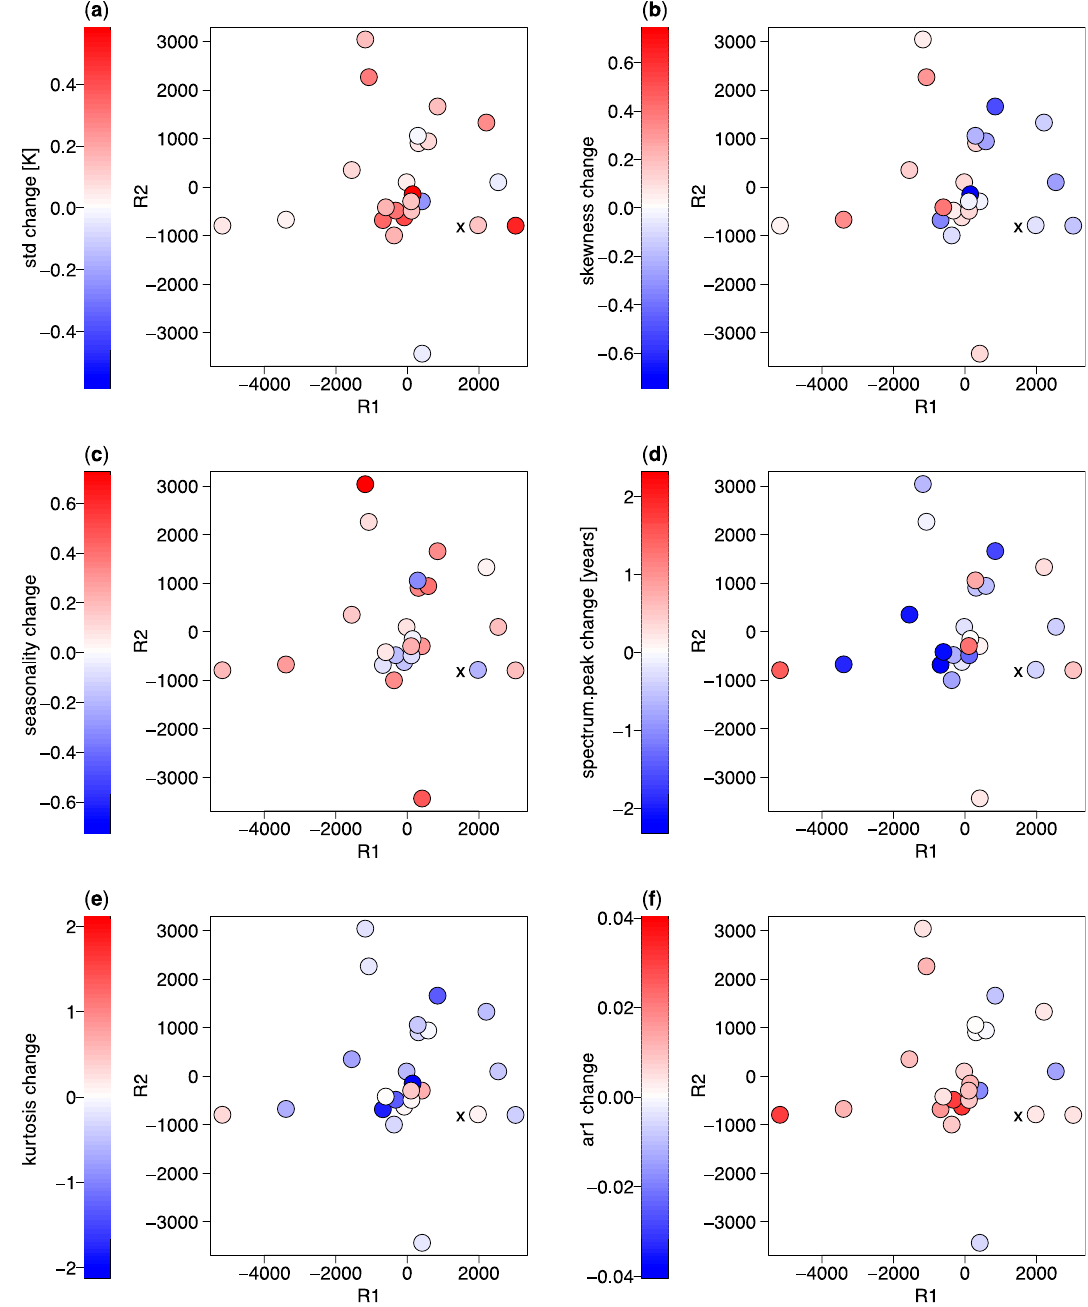
Figure 3. Results of multi-dimensional scaling (MDS) analysis of ENSO probability density functions from CMIP6 climate models. Changes between periods 1850–1949 to 2040–2099 as a function of MDS principal coordinates for Niño 3 ( a ) standard deviation, ( b ) skewness, ( c ) seasonality, ( d ) ENSO spectrum peak, ( e ) kurtosis and ( f ) autocorrelation from CMIP6 models (color) under the SSP585 forcing scenario. Observed coordinates are denoted by black crosses. R 1 and R 2 are the first two principal coordinates of the observed and modelled PDFs of ENSO